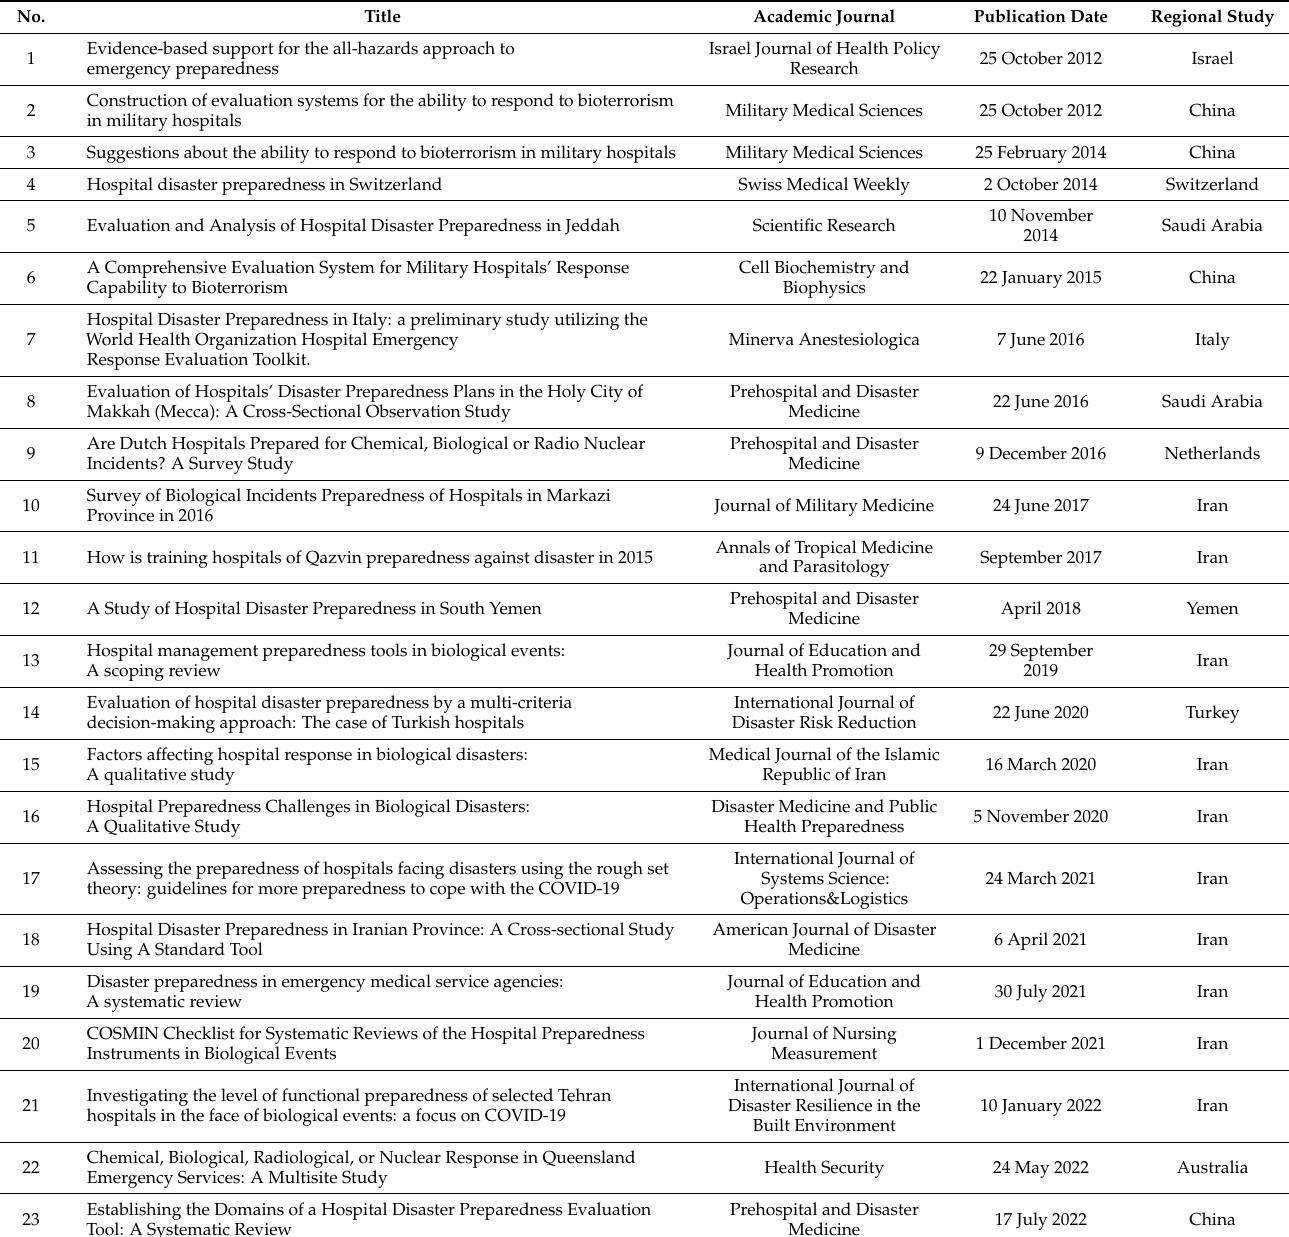
Table 3. Basic information about the 23 articles included in the